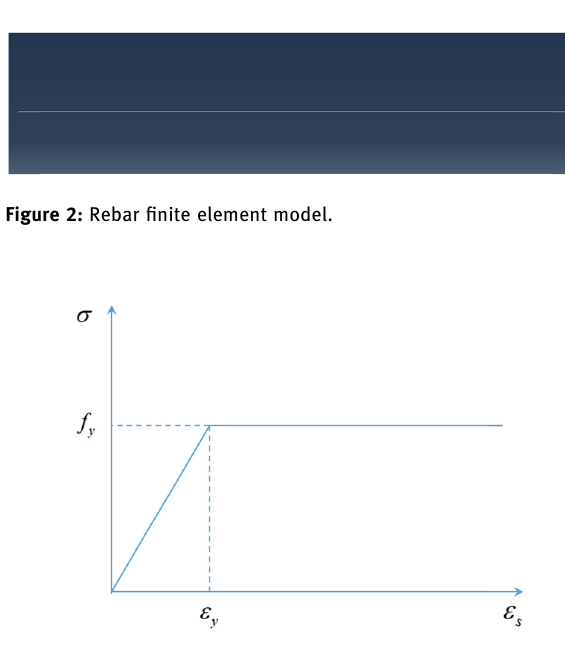
Figure 3: Rebar constitutive relation